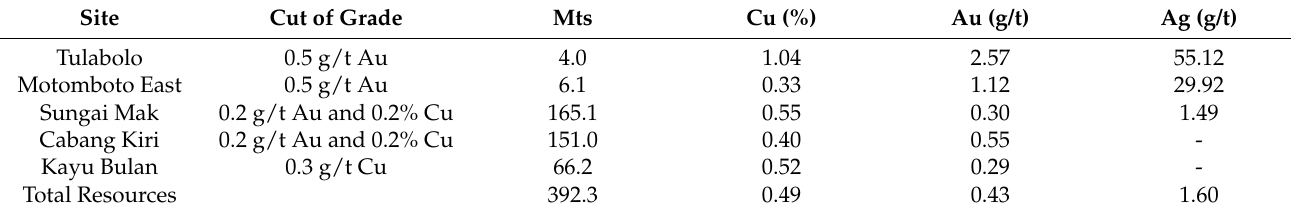
Table 3. Estimated resources by mining